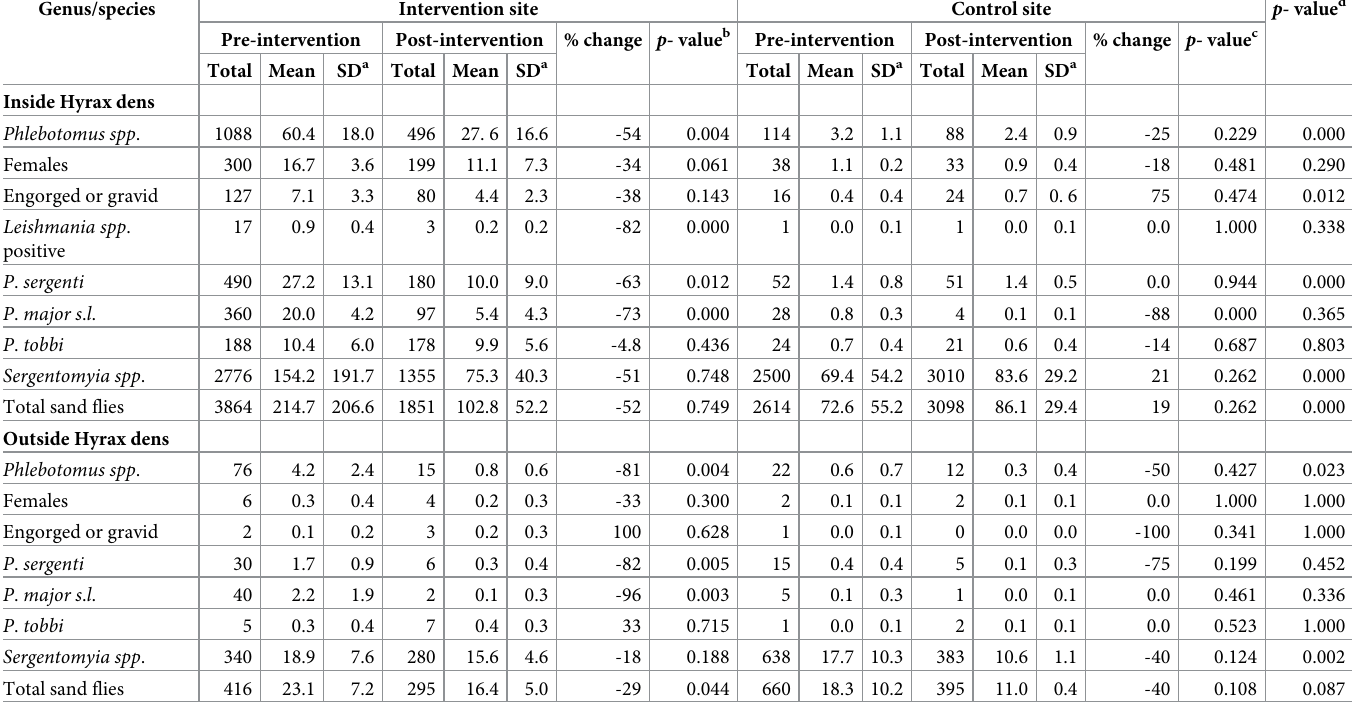
Table 2. Sand fly density and percent change in the intervention (Intervention site) and control (Control site) sites during the pre- and post- intervention period, Tayasir, Palestine, July-September 2019 (N =